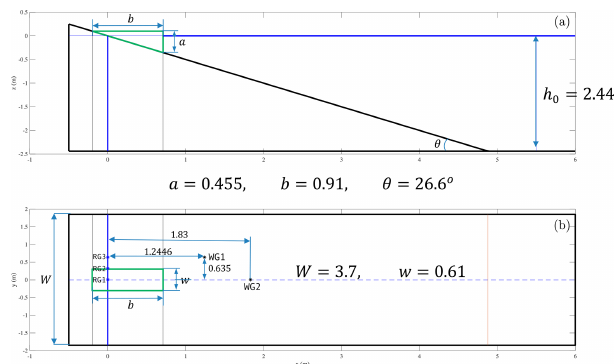
Figure 11. Definition sketch for BP3 laboratory experiments – here for a submerged ( (cid:49) < 0) slide. The upper panel shows the vertical cross section; the lower panel shows the plan view. All units are in meters.